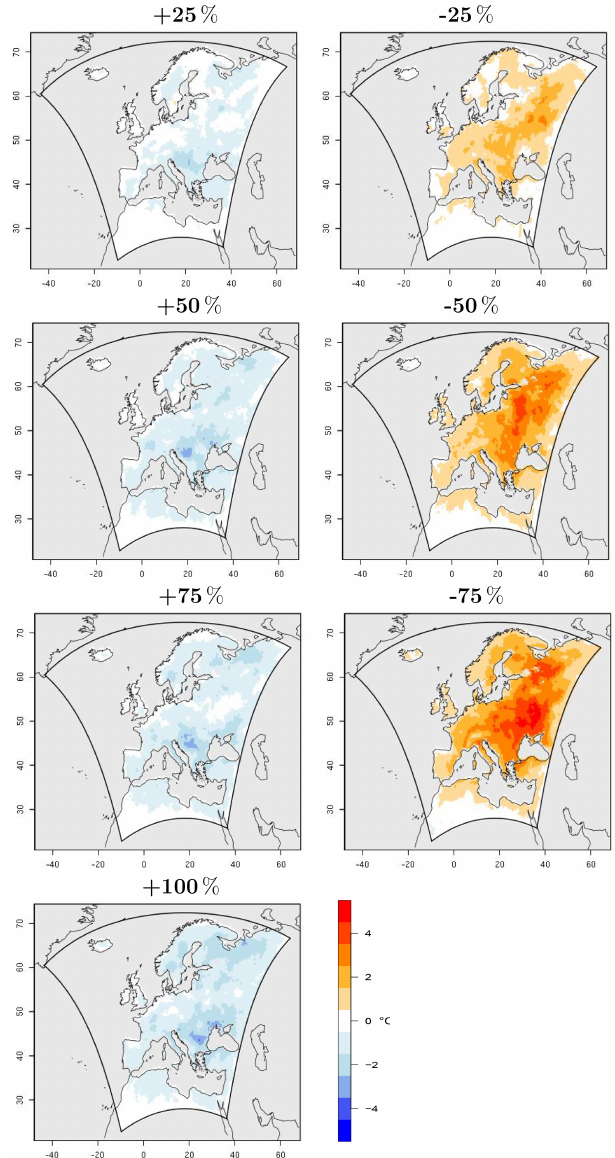
Figure 5. Differences in summer (JJA) mean near-surface temper- ature calculated between each of the perturbed soil moisture exper- iments and the simulation with initial half-saturated soil levels. The left column shows the results of an increase in initial spring soil moisture by 25%, 50%, 75% and 100% from top to bottom, re- spectively. The right column shows the results obtained with drier initial soil moisture conditions, by 25%, 50% and